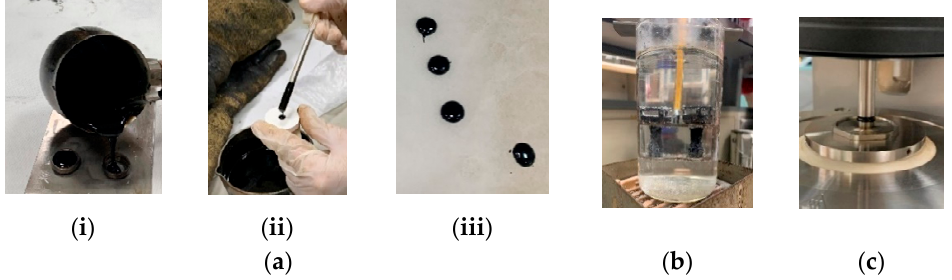
Figure 9. Investigation of asphalt mastics: ( a ) sample preparation: ( i ) R&B, ( ii ) FS, and ( iii ) final specimens for FS test; ( b ) Ring and ball test; ( c ) DSR configuration with 8 mm plate–plate geometry for conducting FS test.